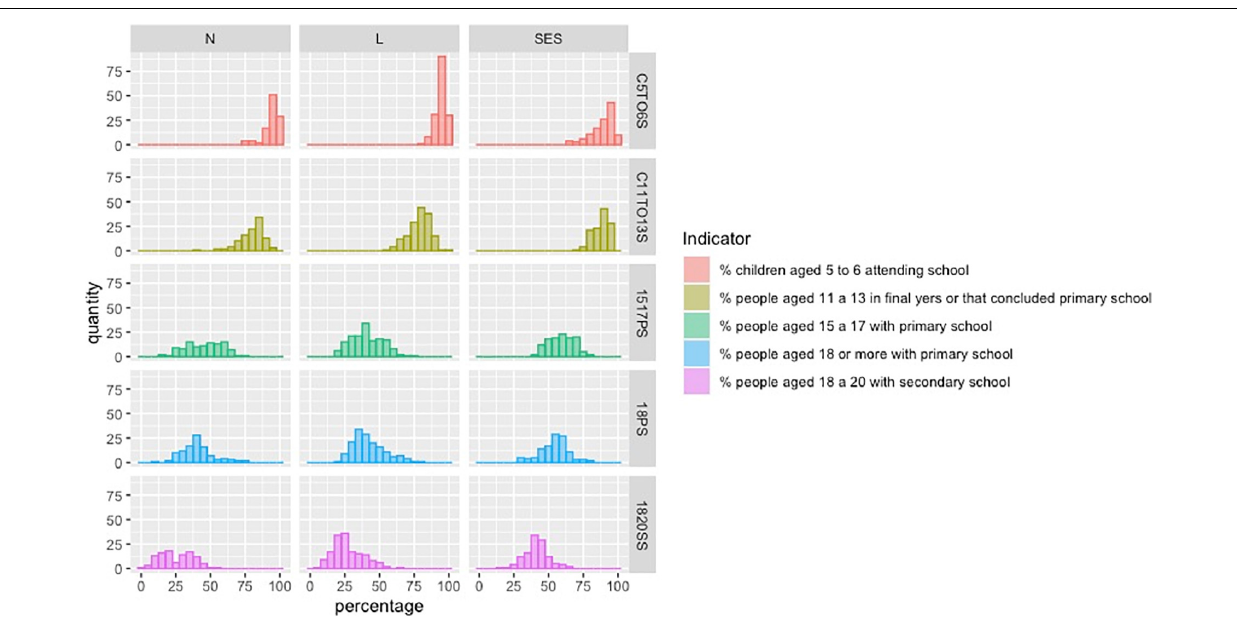
Frontiers in Ecology and Evolution |